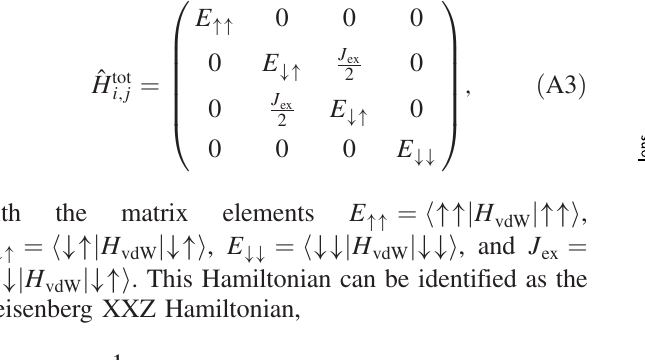
FIG. 8. Reconstruction of the magnetization. Left: measure- ments of the total number of spins M ↑ the population in the j ↑ i state M ↑ ð ϕ Þ after a readout pulse of phase ϕ . Both are affected by the population in auxiliary states N . The measurement M ↑ is fitted by a sinusoidal function a (orange line), from which we extract the mean value amplitude A of the fit, normalized by the total number of spin N ↑ , indicates the magnetization in the xy þ ↓